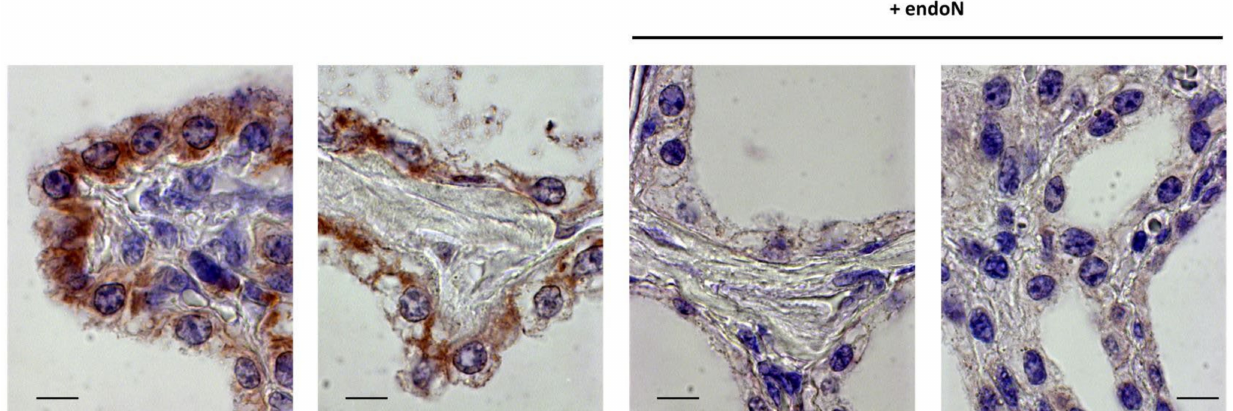
Figure 4. Visualization of polySia in udder tissue. For the immunohistochemical localization of polySia in udder, tissue sections were pretreated with trypsin and stained with the mAb 735 against polySia. For the negative control, the tissue samples were additionally incubated with endoN to degrade polySia. The sections were counterstained with hematoxylin. Scale bar: 10 µ